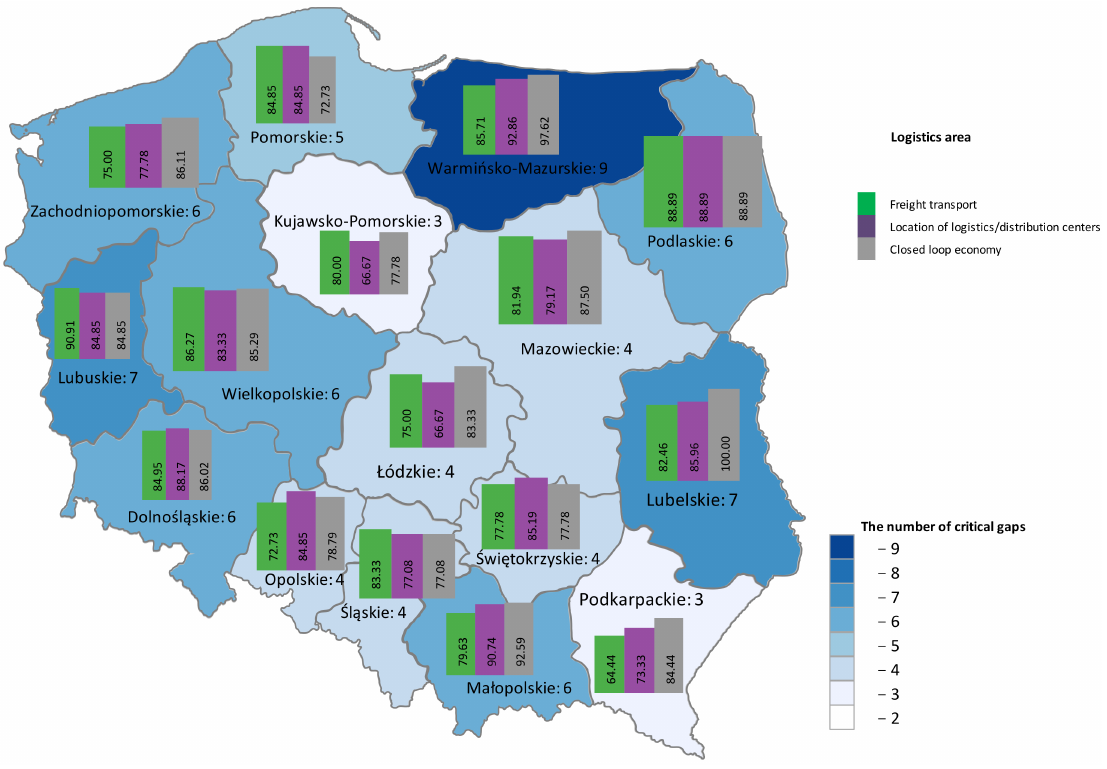
Figure 4. Regional gaps in logistics